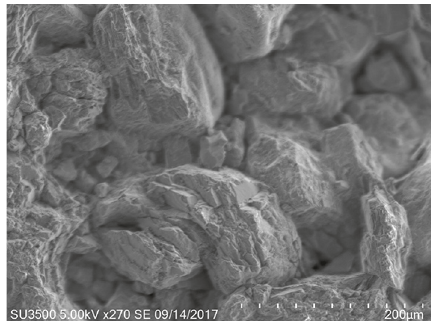
Figure 2: Electron microscopy of the